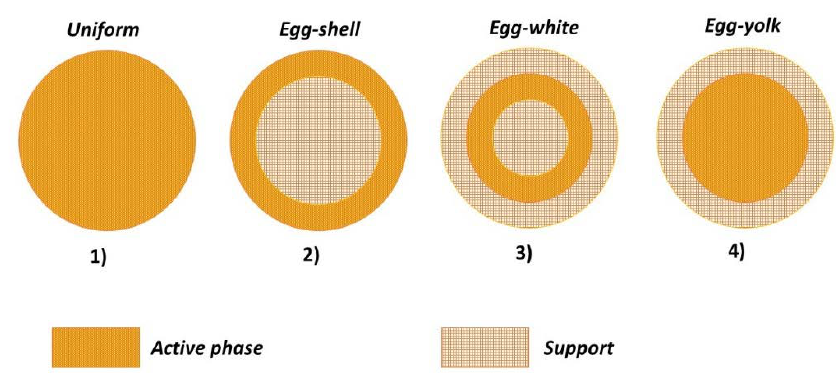
Figure 1. Active phase distributions for a spherical catalyst particle.